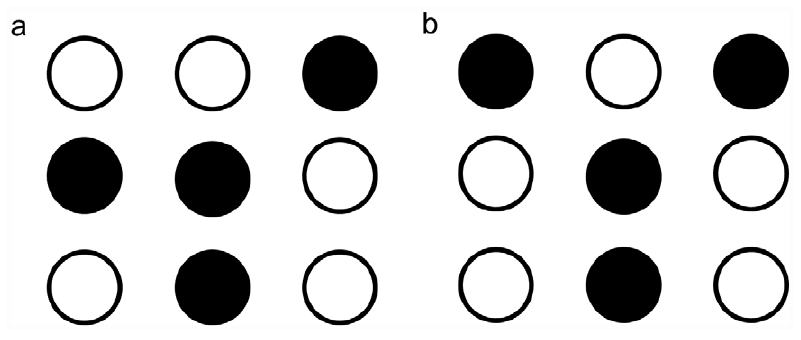
Figure 11. The black nodes represent the points in Q.